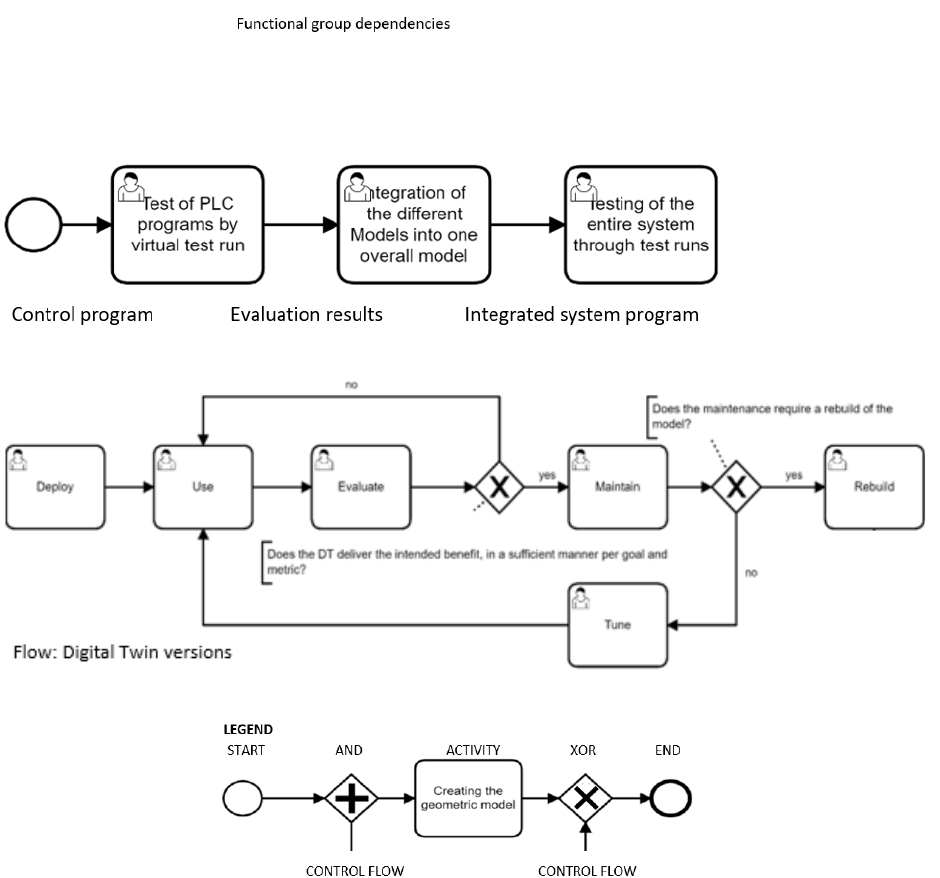
Figure 8. Sequence of steps for DT design, development, verification/validation, deployment and operation in manufacturing.